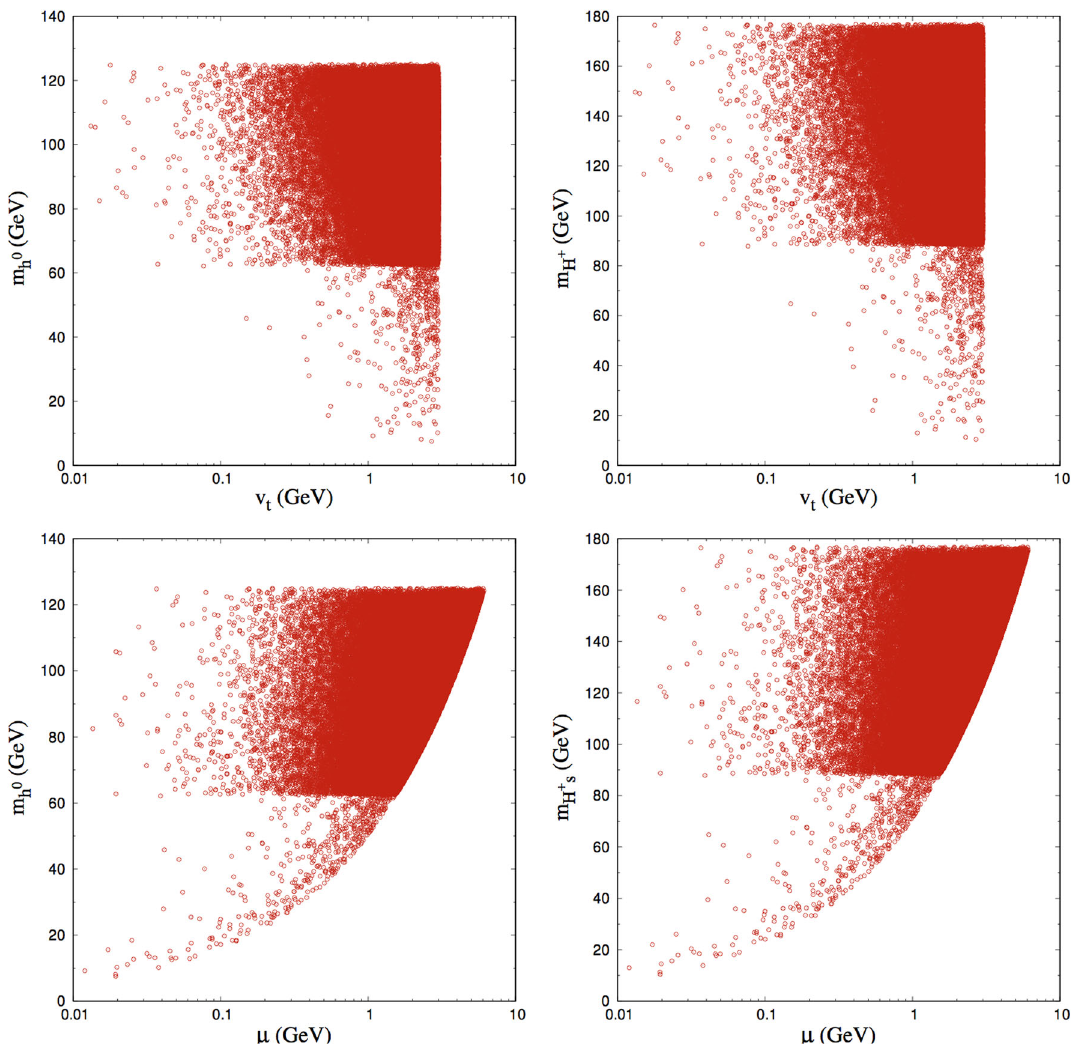
Fig. 6 m h 0 (left) and m H ± (right) dependences on v t (upper panel) and μ (lower panel). Input parameters are: λ ≈ 0 . 52 ( m H 0 ≈ 125 GeV), | λ | ≤ 1 . 5, 0 ≤ λ ≤ 1, 10 − 2 ≤ μ ≤ 10 (GeV) and 10 − 2 ≤ v a b